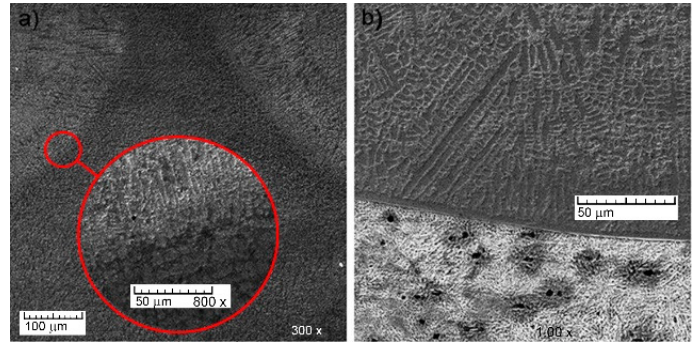
Figure 21. Features of the double layer formation: ( a ) junction of two bronze tracks with 12N-01 alloy track; ( b ) transfer zone between the alloy track and steel bottom.